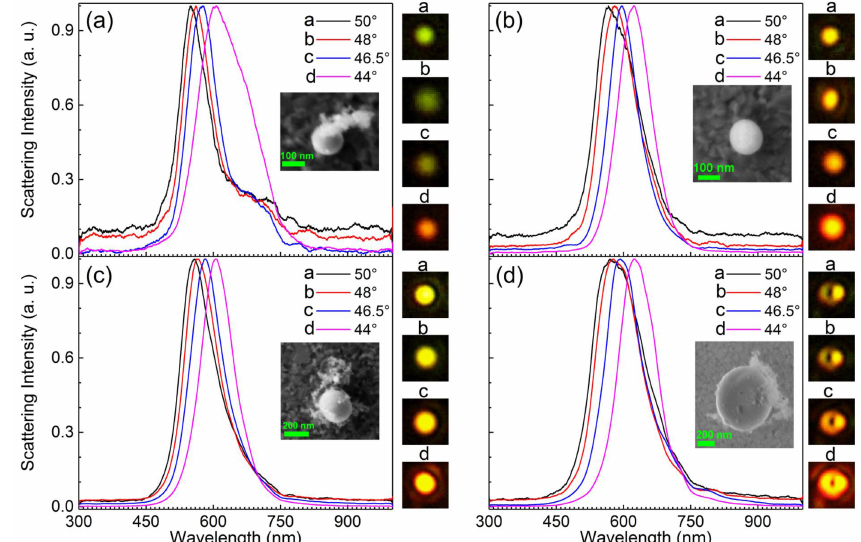
Figure 4. Measured scattering spectra for Ga NPs with different diameters on the Au/SiO 2 substrate, which are excited by the SPPs generated at different incidence angles. ( a ) d = 146 ± 2 nm, ( b ) d = 165 ± 2 nm, ( c ) d = 281 ± 2 nm and ( d ) d = 657 ± 2 nm. In each case, the SEM images